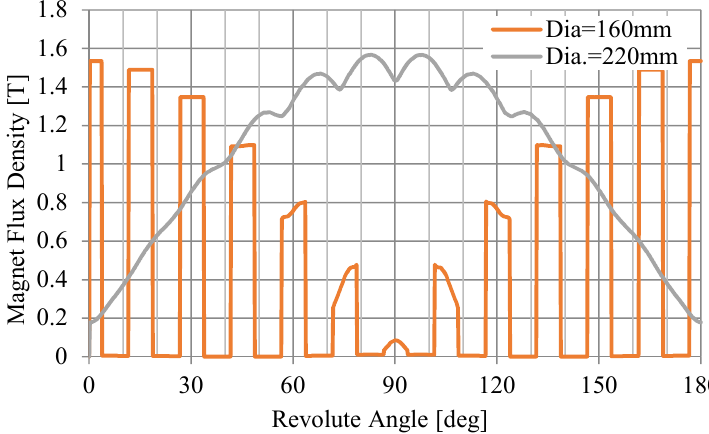
Figure 4. The magnetic flux density on the inner contour of the stator under no load.